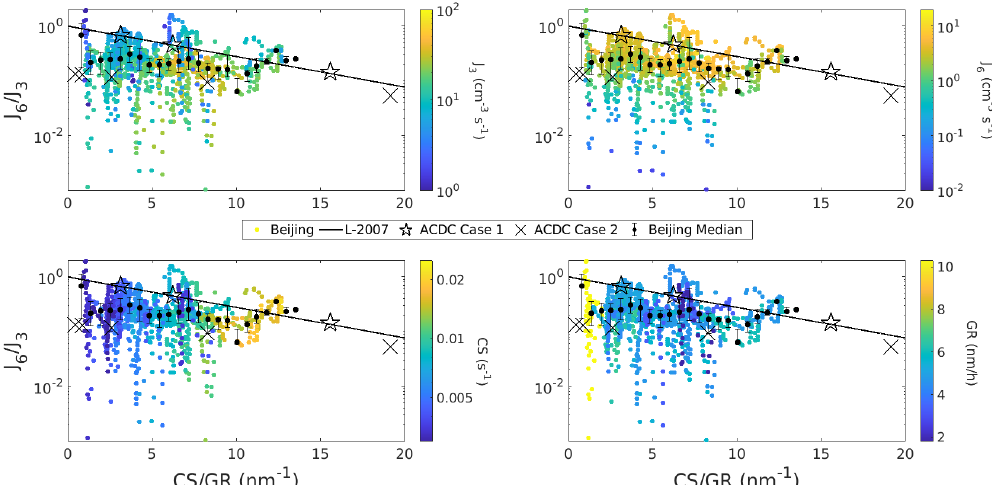
Figure 8. Survival probability from 3 to 6nm ( J 6 /J 3 ) as a function of the ratio of condensation sink and growth rate (CS / GR). Survival probabilities from Beijing, China, ACDC model simulations, and the predictions based on the theoretical formulation by Lehtinen et al. (2007) (L-2007) are included. ACDC Case 1 refers to simulations with no collisions between the clusters, while in Case 2 simulations, cluster– cluster collisions also occurred. Median values for observed J 6 /J 3 have been determined based on a bin division of horizontal values and the quartiles are shown as the error bars. The top left figure is shaded with the J 3 while the top right, the bottom left, and the bottom right are shaded with the J 6 , the CS, and the GR, respectively.